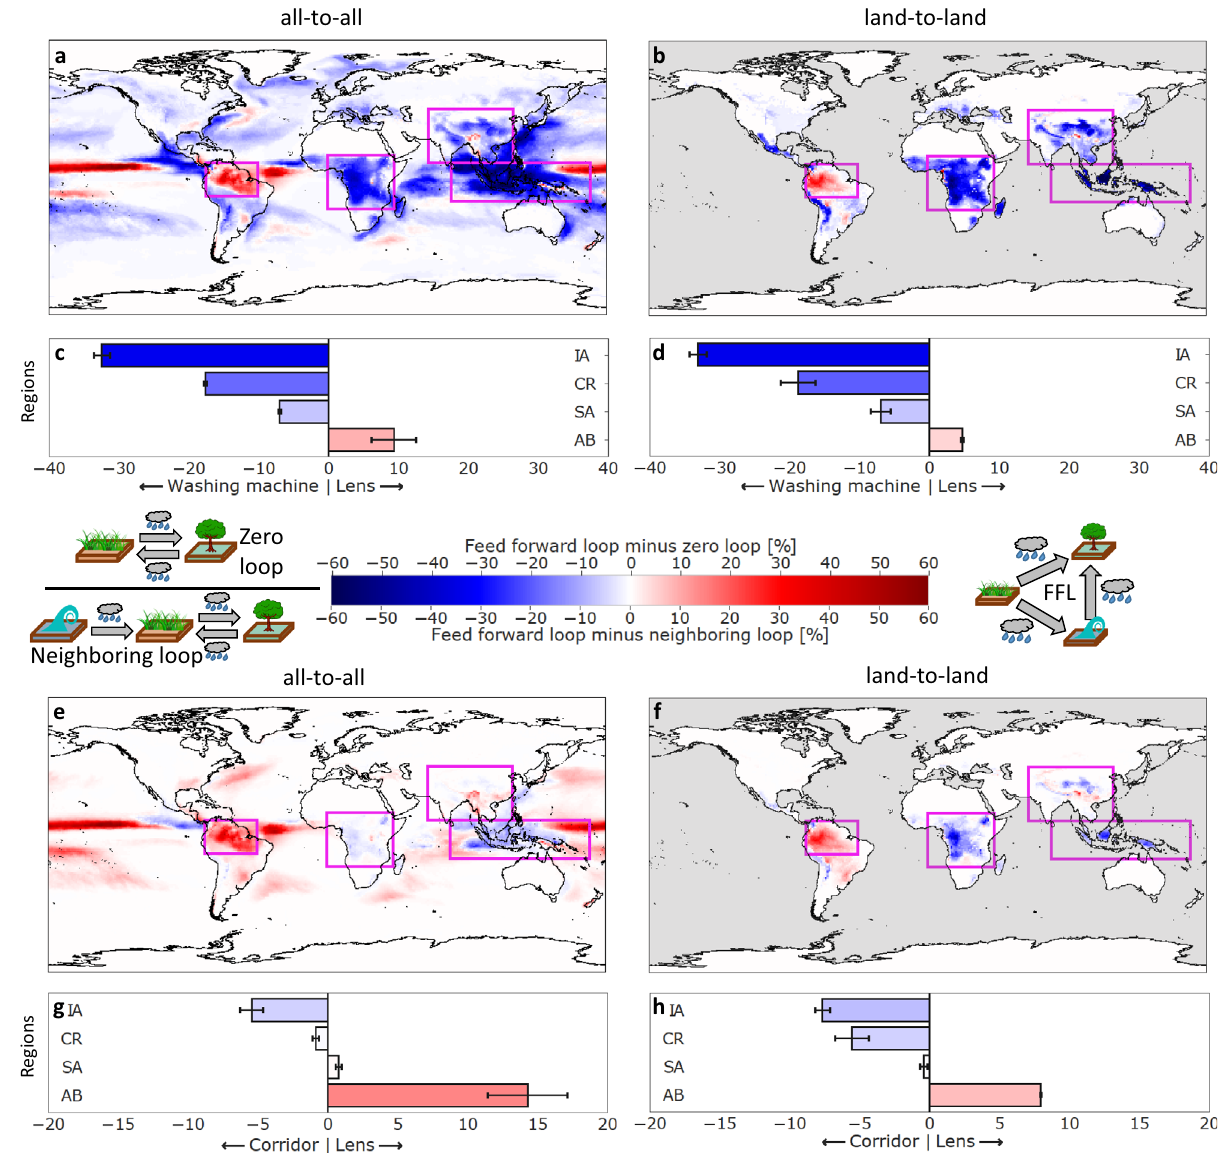
Fig. 2 | Characterization of the Earth ’ s moisture recycling hubs. a FFL (feed- forward loop) and ZL (zero loop) strength difference for the all-to-all network and b for the land-to-land network. The corresponding spatially aggregated averages are shown in panels c , d . Illustrations next to the color bar schematically illustrate the motifs. The four main moisture recycling regions can be clearly distinguished. Redder colors represent larger lensing of moisture fl ows; bluer colors represent reciprocityofthenetworkstructure.Therefore,theAmazonbasin(AB)isadirected lens, while the Indonesian Archipelago (IA), the Congo rainforest (CR), and South Asia (SA) are washing machines in descending order. e – h Same as a – d but for FFL